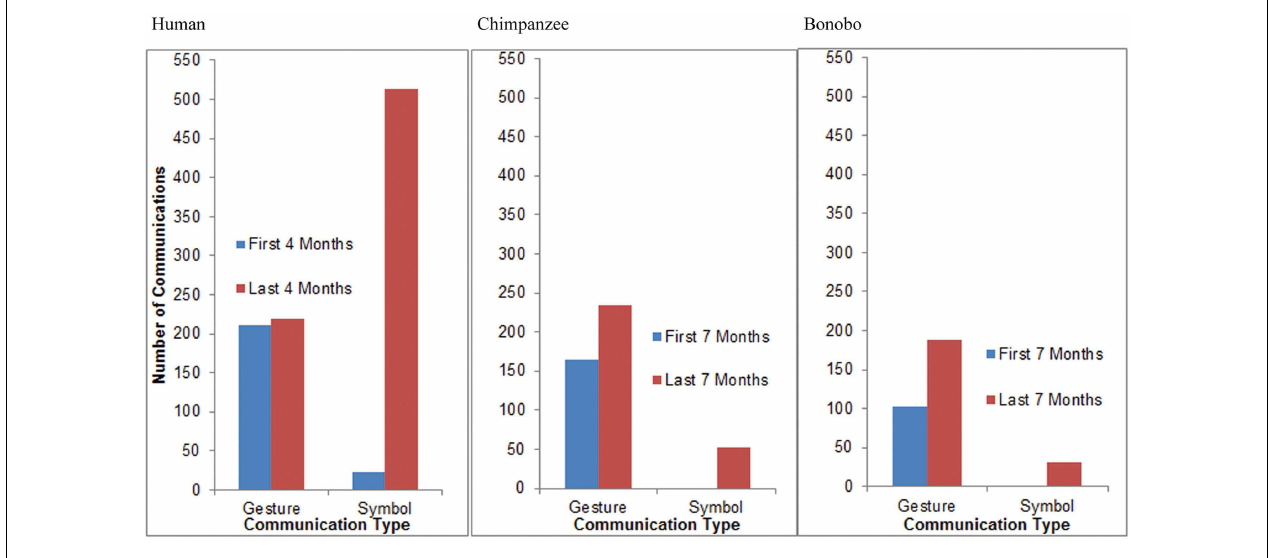
7months of the study, but, because of the necessary scale of the graphs to capture high frequency categories, they are not visible in the right-hand